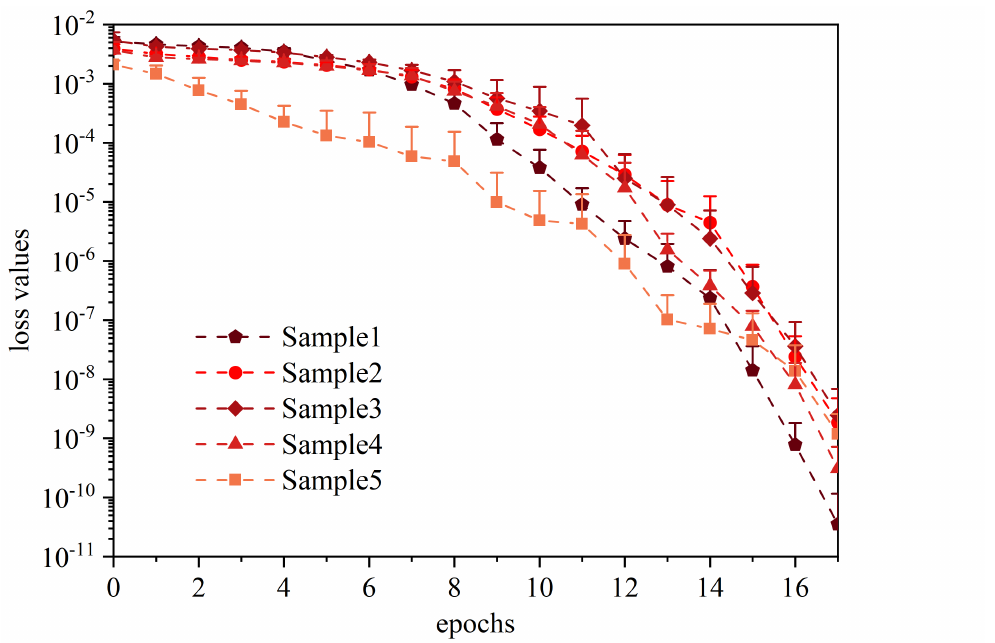
Figure 2. Convergence of the loss values towards the minimum with the number of iterations. The different lines correspond to five sets of independently generated training data with size N s = 50. The error bar shows the standard derivation with respect to the mean value for 10 different runs, with random initialization for each training